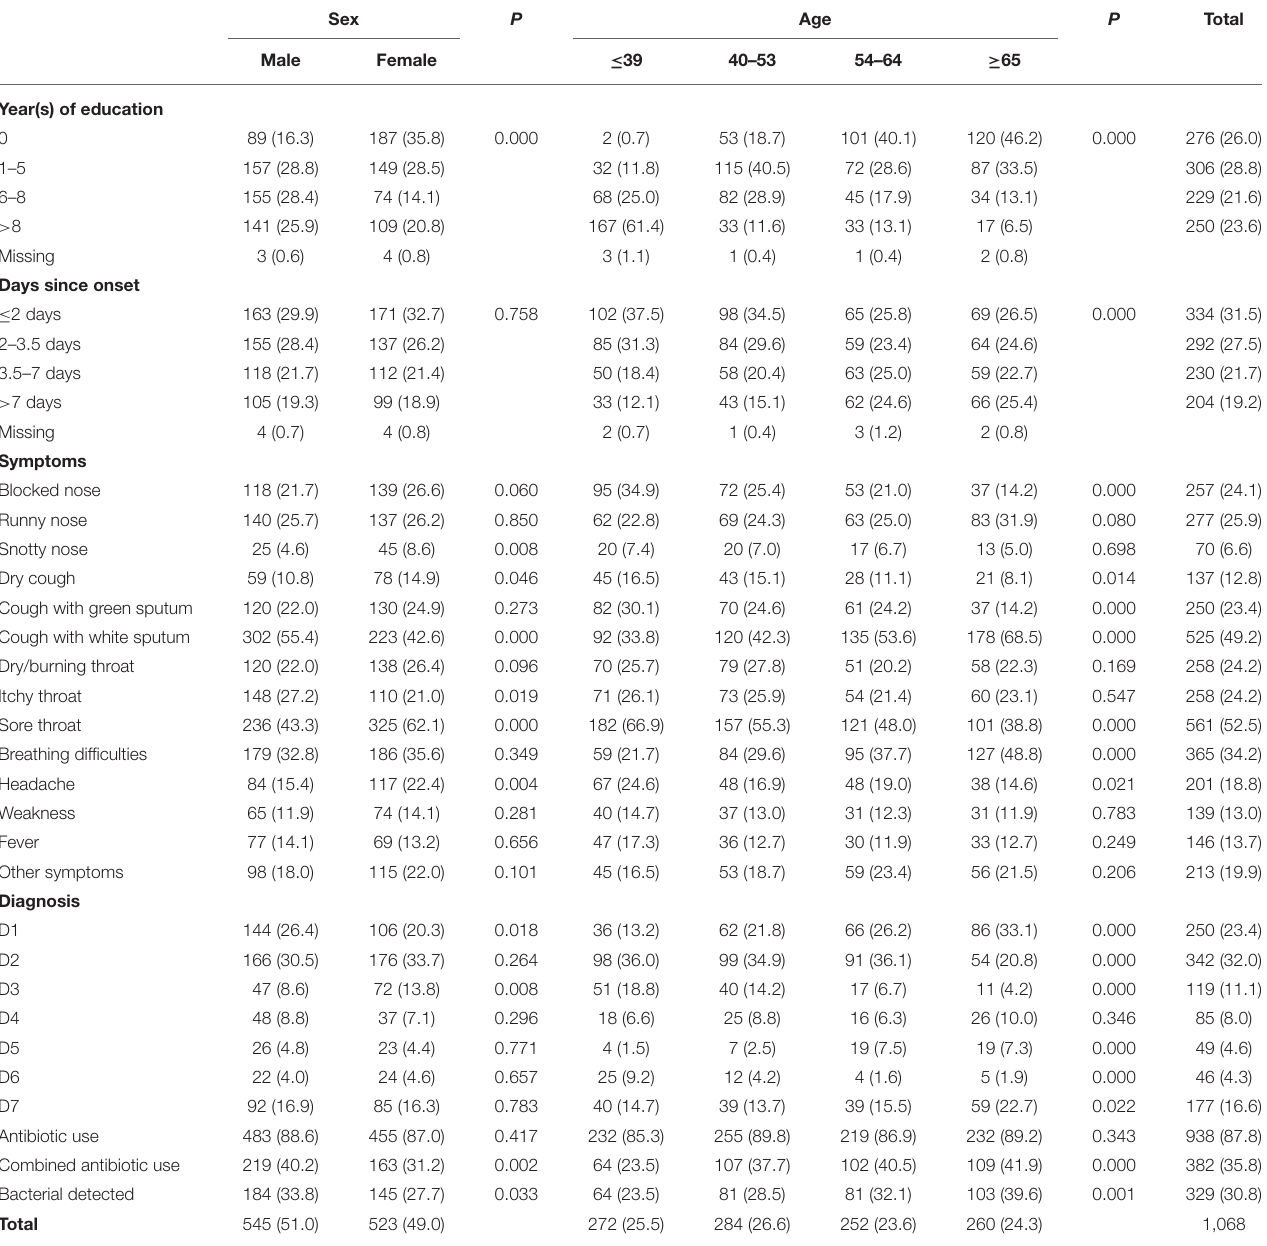
TABLE 1 | Descriptive statistics of antibiotics prescription, symptoms, diagnosis and common socio-demographics, N